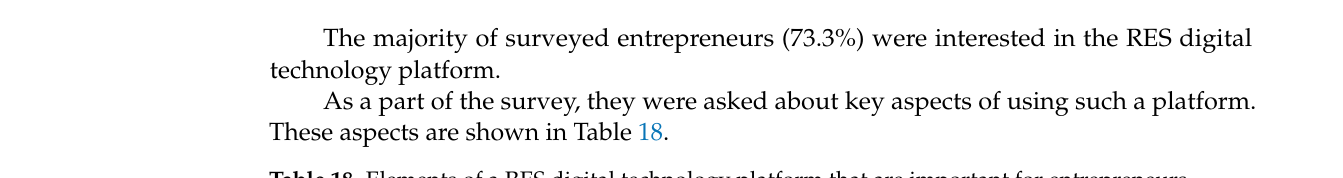
Table 18. Elements of a RES digital technology platform that are important for